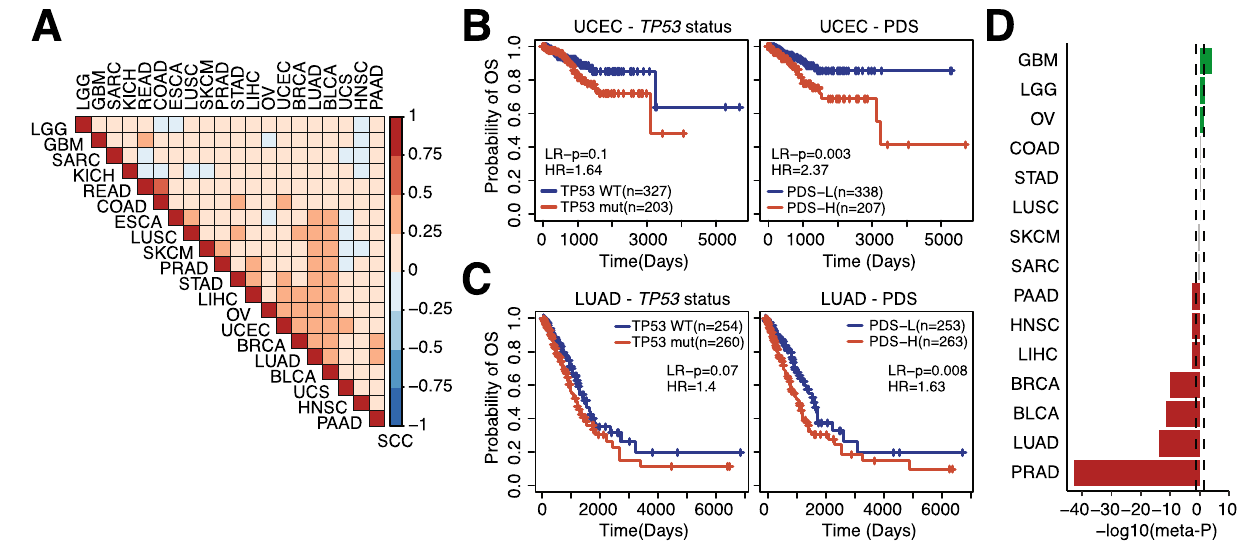
Figure 1. Prognostic associations in TCGA and PRECOG. ( A ) Correlation matrix of TP53 signatures using Spearman correlation coefficients (SCC). ( B ) KM plots for UCEC in TCGA based on TP53 mutation status (left) or p53 deficiency scores (PDS) (right). ( C ) KM plots for LUAD in TCGA based on TP53 mutation status (left) or PDS (right). LR p-value calculated between groups using Log-rang tests, HR hazard ratio. ( D ) Meta- p-values for association between PDSs and prognosis in PRECOG. Bars indicate − log10(meta p-values). Negative values indicate a hazardous role for PDSs, while positive values represent protective associations. LGG (brain lower grade glioma), GBM (glioblastoma multiforme), SARC (sarcoma), KICH (kidney chromophobe), READ (rectum adenocarcinoma), COAD (colon adenocarcinoma), ESCA (esophageal carcinoma), LUSC (lung squamous cell carcinoma), SKCM (skin cutaneous melanoma), PRAD (prostate adenocarcinoma), STAD (stomach adenocarcinoma), LIHC (liver hepatocellular carcinoma), OV (ovarian serous cystadenocarcinoma), UCEC (uterine corpus endometrial carcinoma), BRCA (breast invasive carcinoma), LUAD (lung adenocarcinoma), BLCA (bladder urothelial carcinoma), UCS (uterine carcinosarcoma), HNSC (head and neck squamous cell carcinoma), PAAD (pancreatic adenocarcinoma).